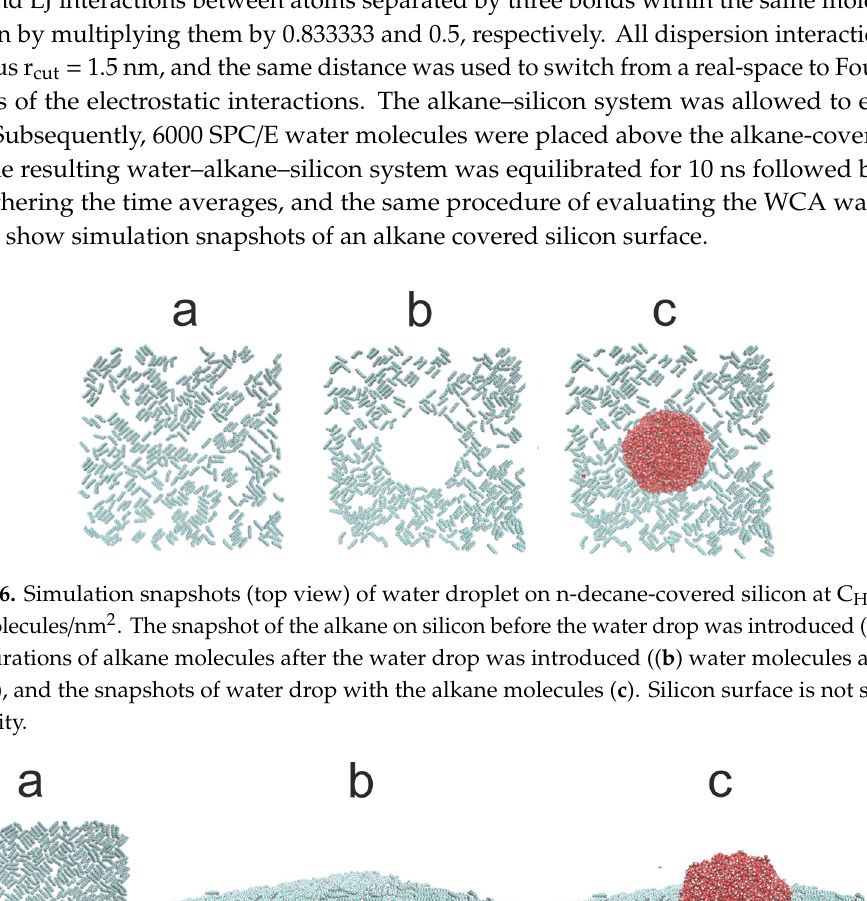
Figure 7. Simulation snapshots (side view) of water droplet on n-decane-covered silicon at C HYDR = 1.29 molec / nm 2 . The snapshot of the alkane on silicon before the water drop was introduced ( a ), the configurations of alkane molecules after the water drop was introduced (( b ) water molecules are not shown), and the snapshots of water drop with the alkane molecules ( c ). Silicon surface is not shown for better clarity.